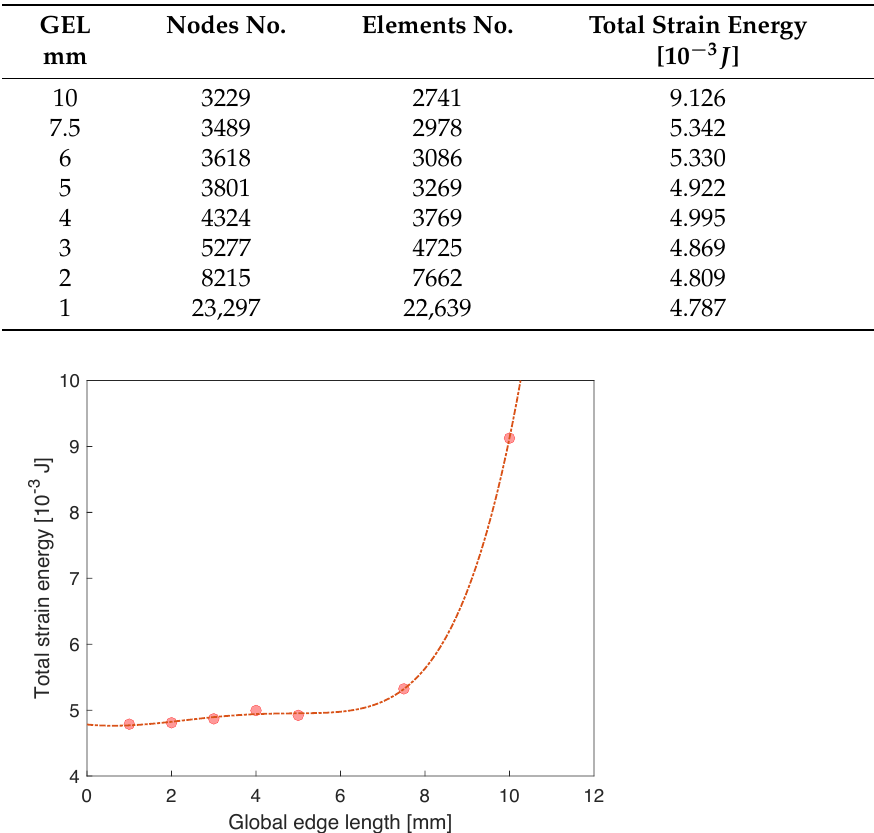
Table 14. Mesh convergence through gradually smaller element dimensions, expressed in terms of Global Edge Length.